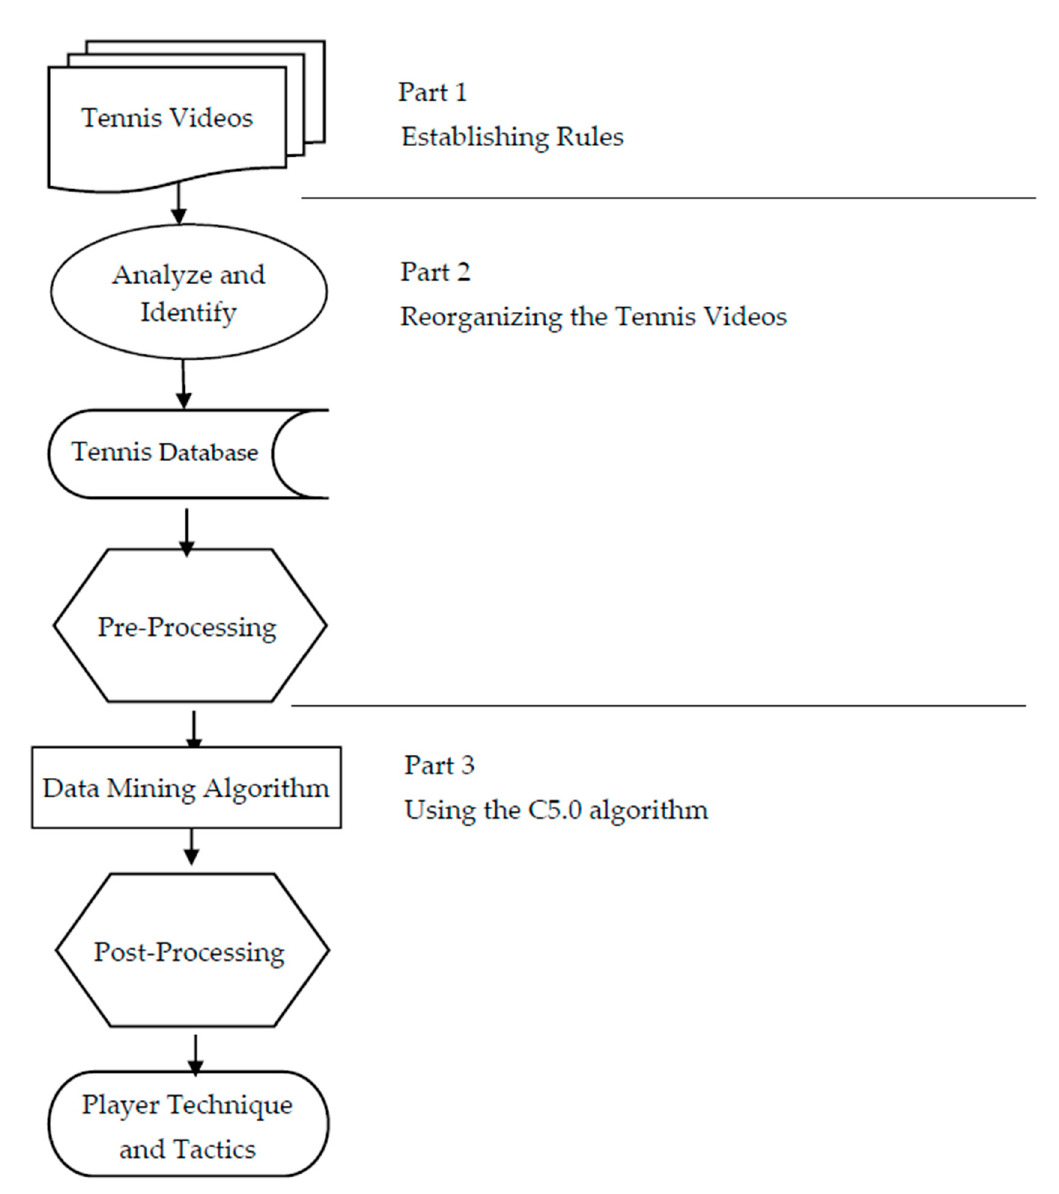
Figure 1. Flow diagram representing the technical and tactical decision-making process. Part 1: Establishing Table 1. Tennis techniques and players’ performance algorithm codes. Tennis Techniques and Players’ Performance